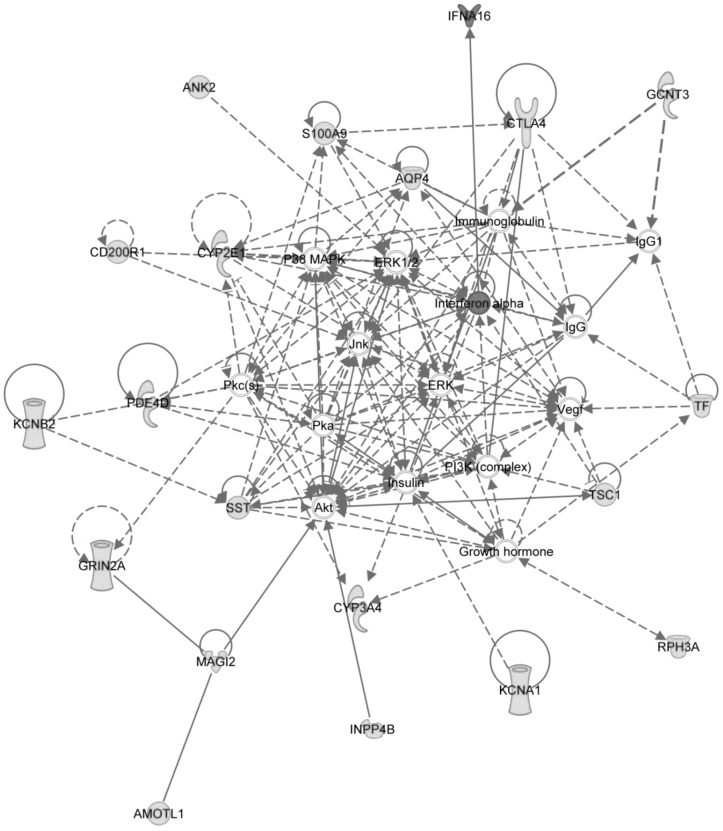
Network of differentially expressed genes.This network contains interconnections among 20 differentially expressed genes in response to HCV-core protein stimulation. Upregulated genes are indicated in green, and downregulated genes and gene classes in red. These differentially expressed genes include the cytotoxic T lymphocyte associated protein CTLA4, the cytochrome P450 proteins CYP2E1 and CYP3A4, the potassium voltage gated proteins KCNA1 and KCNB2, and the cell surface receptor CD200R1.